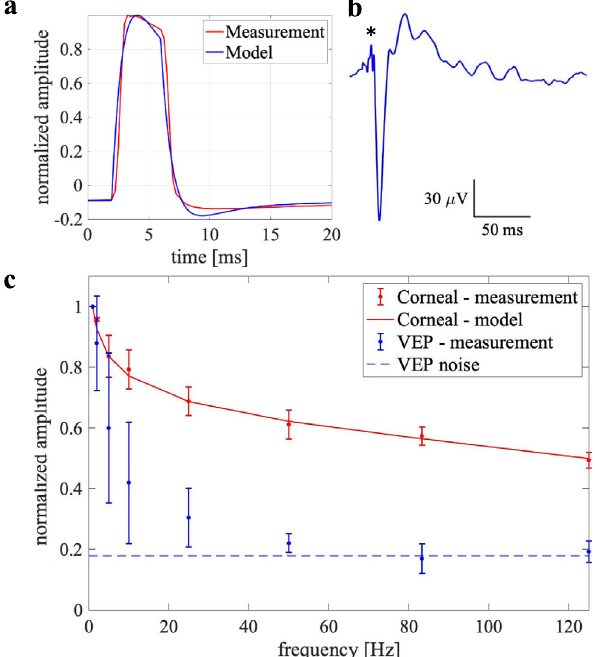
Fig. 5 | In-vivo validation of the model. Far- fi eld electric potential in the eye: measurements and modeling. a Measured and modeled corneal potential gener- ated by a 4ms pulse at 1.2mW/mm 2 full- fi eld illumination. b Visually evoked potential in response to 4ms pulses applied at 5Hz repetition rate. Asterisk indi- cates the 4ms-long positive stimulus artifact. c Peak-to-peak amplitudes of the cornealsignalandVEPinducedbythe4mspulsesatrepetitionratesvaryingfrom1 to 125Hz under full- fi eld illumination, normalized to 1Hz. Modeling result for the corneal signal is shown by a line. For both corneal and VEP measurements, n =3 independent experiments. The error bars represent the standard deviations with centers at mean values. Source data are provided as a source data fi